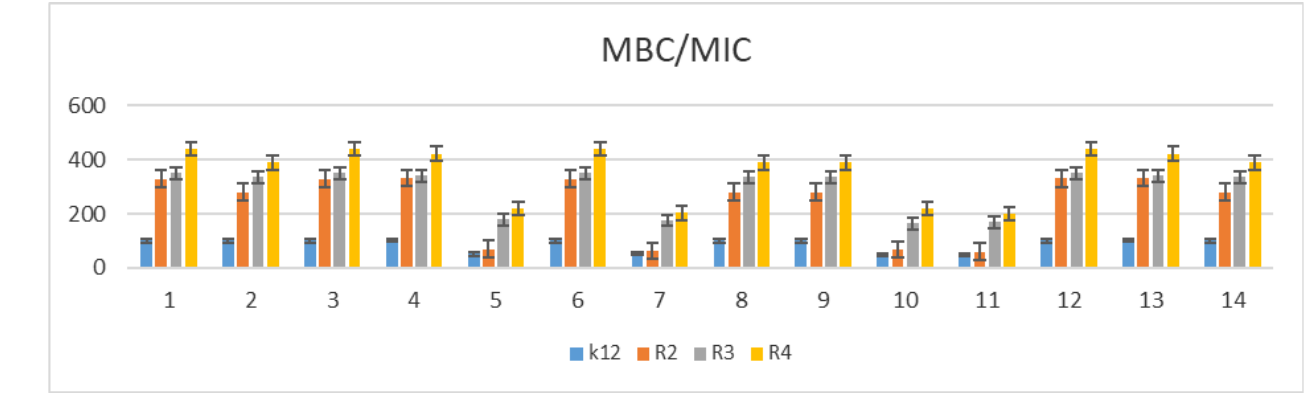
Figure 8. The ratio of MBC/MIC of the p -quinols. The x -axis features compounds 1 – 14 used se- quentially. The y -axis shows the MIC value in µg/mL − 1 . Table 2. Statistical analysis of all analyzed compounds by MIC, MBC, and MBC/MIC; <0.05 *, <0.01 **, <0.001 ***.